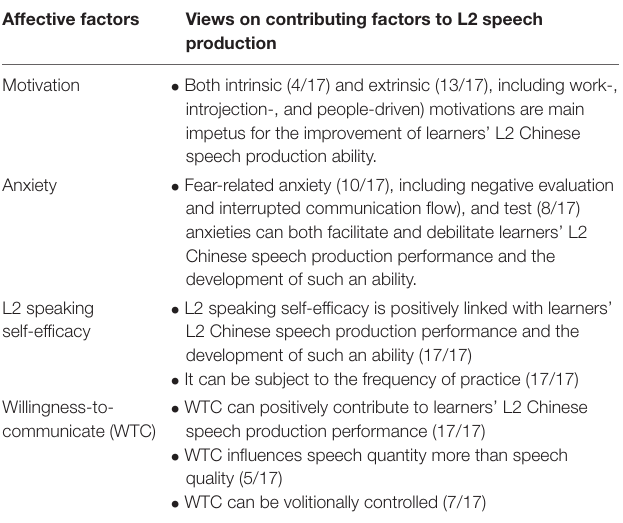
TABLE 3 | Affective dimensions of multilinguals’ L2 Chinese speech